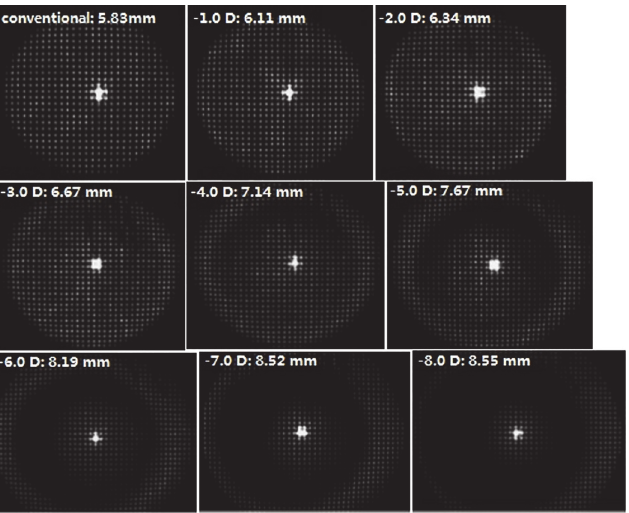
Fig 3. Influence of adjusting spherical error compensation on measured area of wavefront aberration and the impairment of image spots.